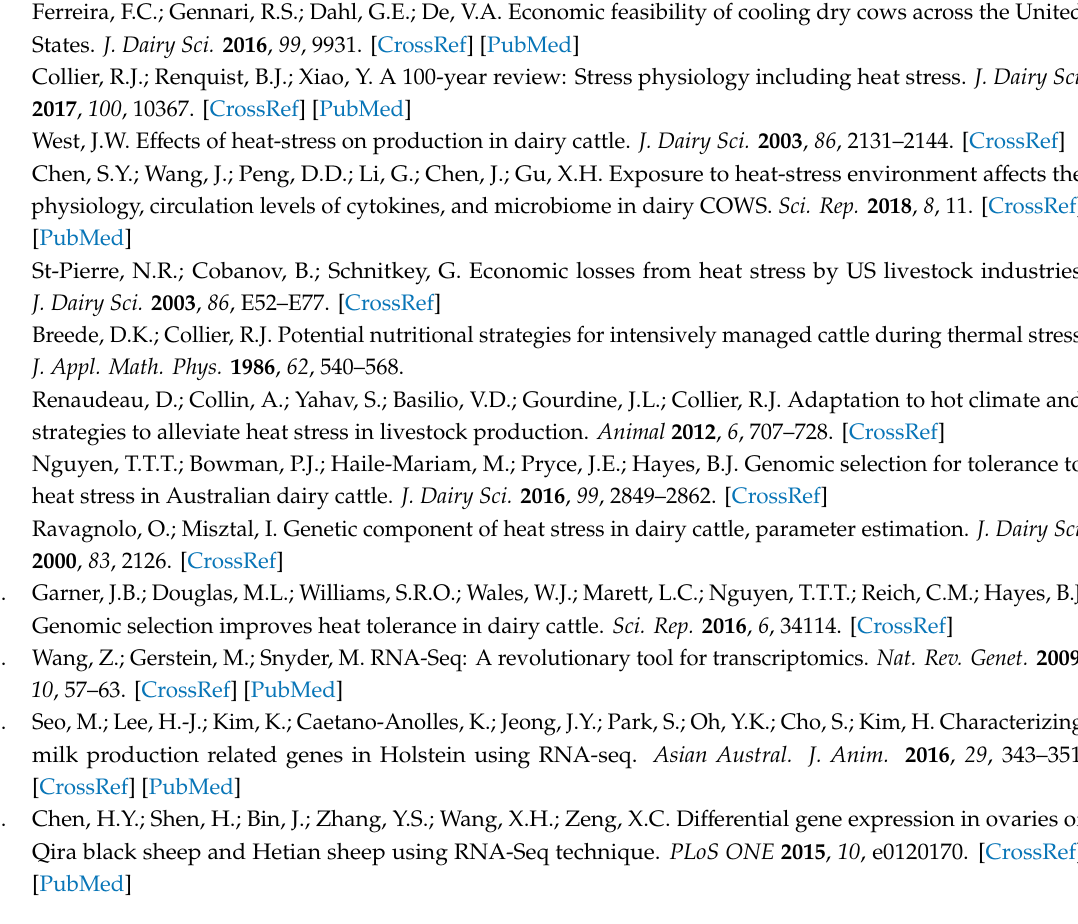
Figure S1: The expression density distribution in five samples, Table S1: Primers for DEGs in RNA-seq, Table S2: Eigen values and variance contribution ratio of measured indicators and characteristic value of principal components, Table S3: Membership value of 42 dairy cows, Table S4: Description of the RNA-Seq data in the 5 dairy cow blood tissues, Table S5: Description of the DEGs, Table S6: The GO and KEGG analysis of